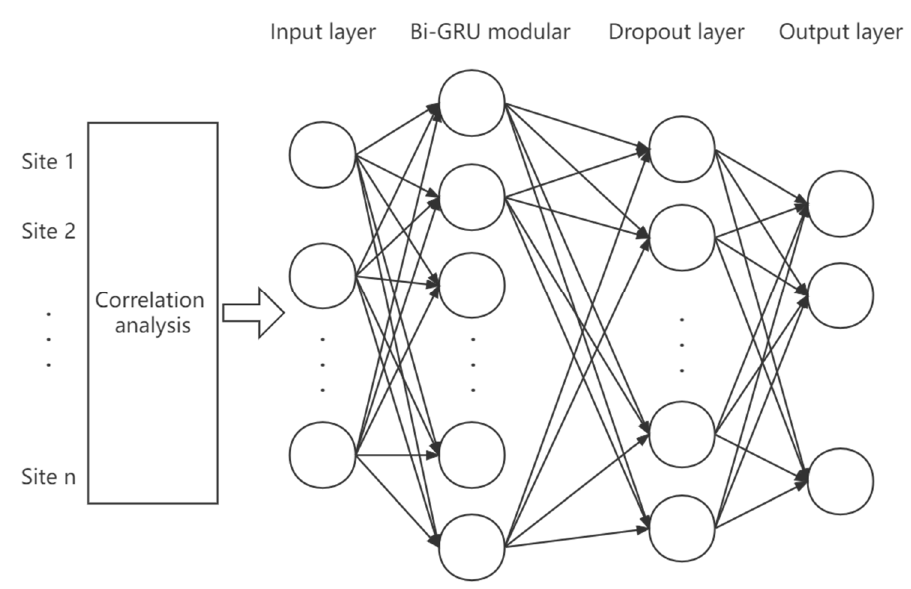
Figure 7. The structure diagram of neural network model based on PCCs-BiGRU.